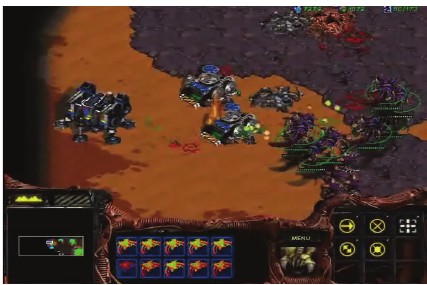
Figure 4: Glest RTS game. Figure 5: StarCraft Brood War RTS